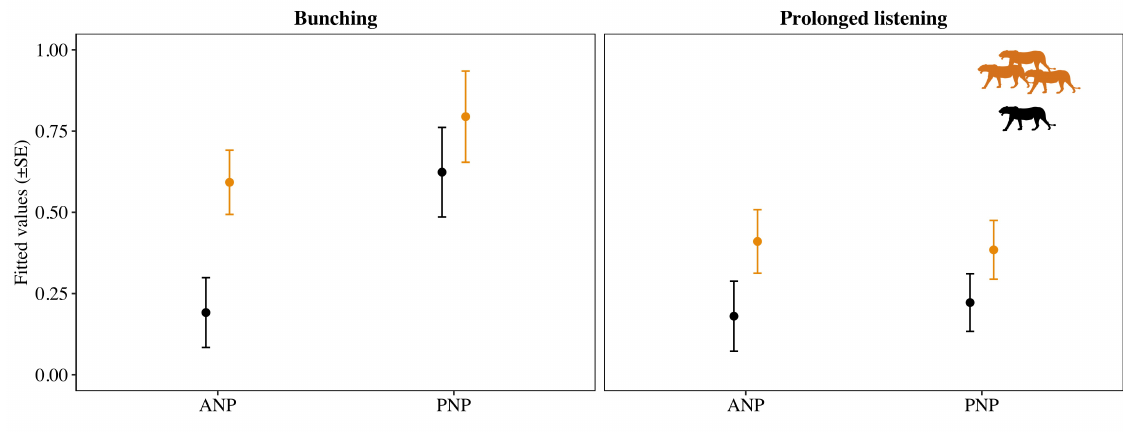
Figure 2. The probability of elephant bunching and prolonged listening during playbacks of one (black) versus three (orange) lions roaring in Amboseli National Park (ANP) and Pilanesberg National Park (PNP). Lion silhouette illustration was created by L.S.C.